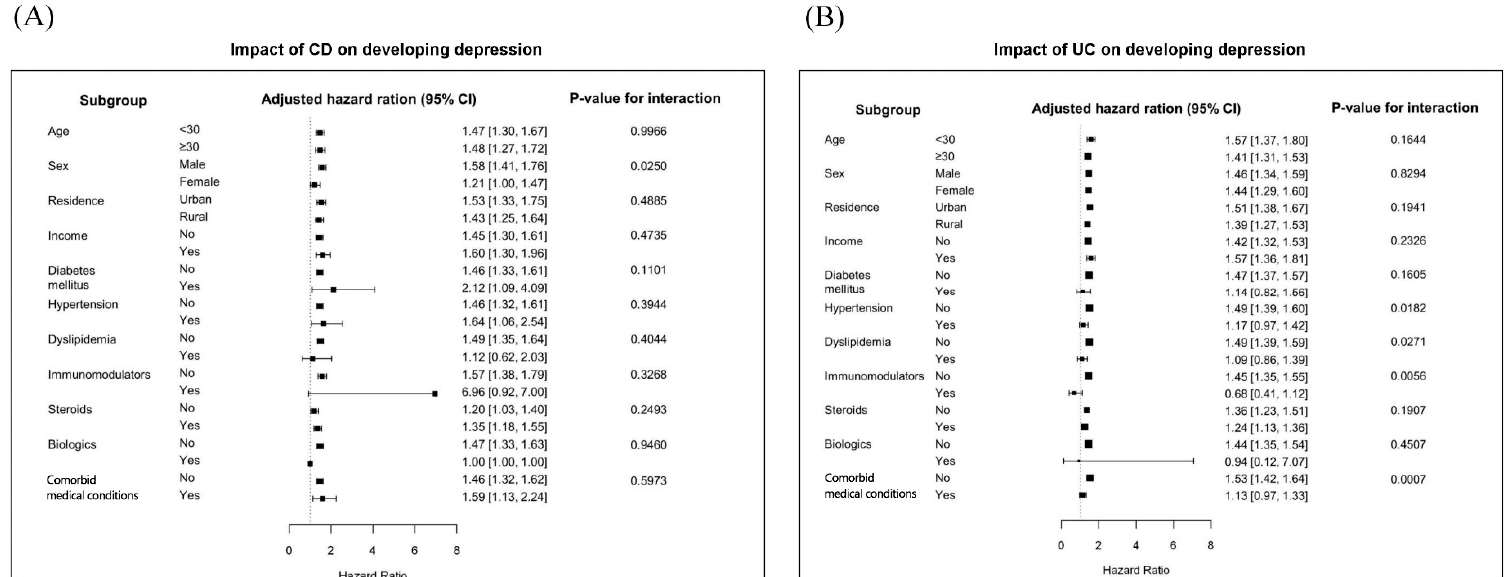
Figure 3. Subgroup analysis for the risk of depression in patients with ( A ) Crohn’s disease; and ( B ) ulcerative colitis compared to control groups. CD, Crohn’s disease; CI, confidence interval; UC, ulcerative colitis.